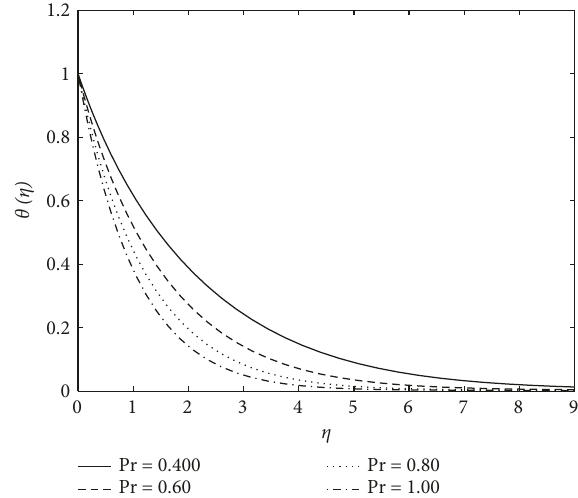
Figure 6: Change in the value of θ ( η ) for different values of λ .